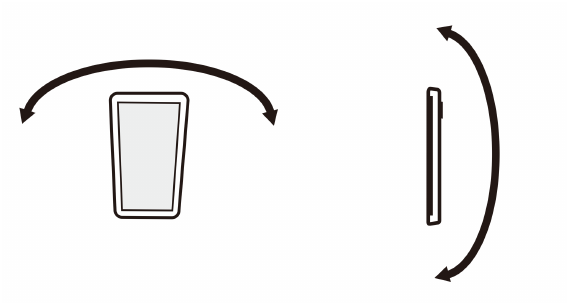
Figure 6. Activities required by the user to measure the activity angle.